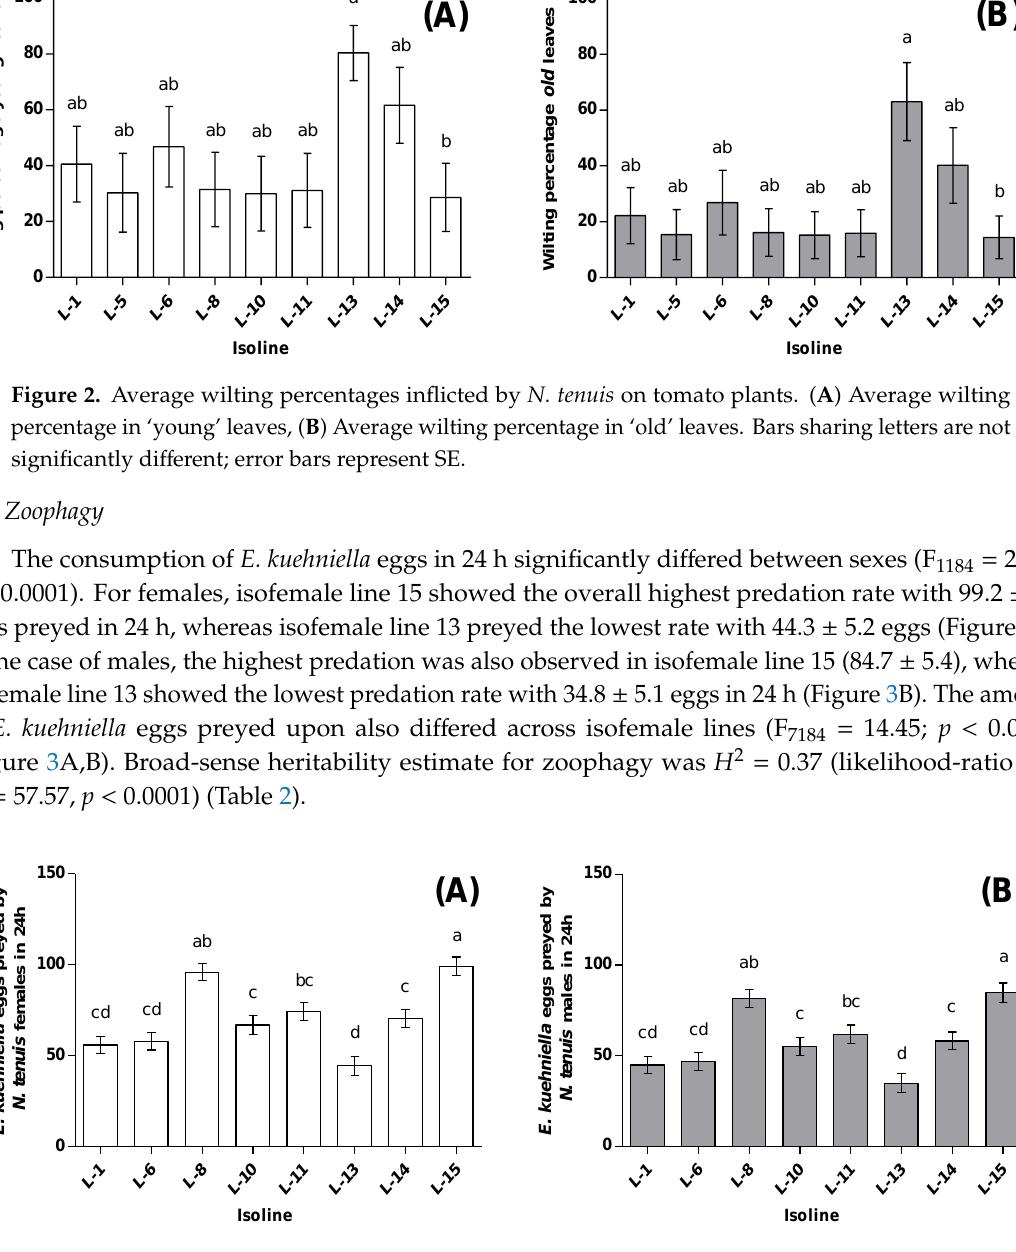
Figure 3. Average E. kuehniella eggs preyed by N. tenuis in 24 h. ( A ) Average E. kuehniella eggs preyed by N. tenuis females ( B ) Average E. kuehniella eggs preyed by N. tenuis males. Bars sharing letters are not significantly different; error bars represent SE.